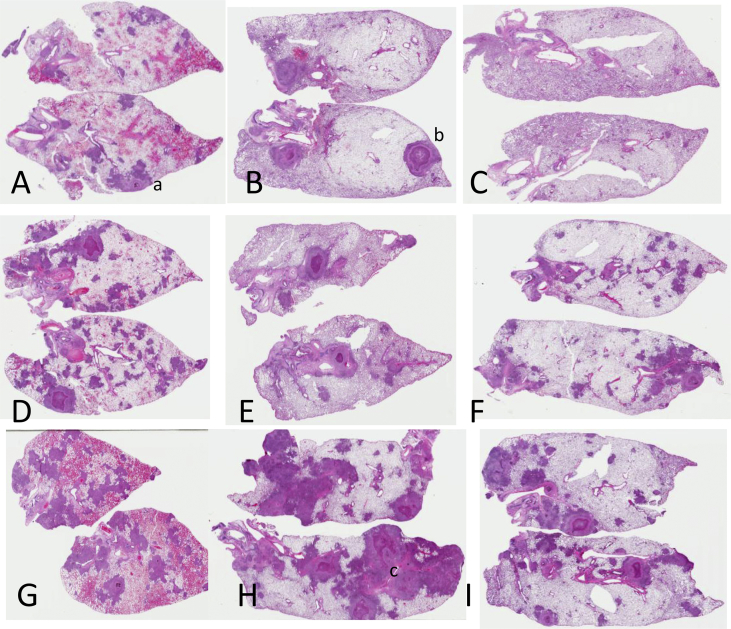
Representative whole lung scans from infected guinea pigs harvested on day-60 of the infection. Hematoxylin and eosin staining. The top row [A-C] are high transmission strains 708, 1009, and 212. The middle line [D-F] are moderately transmitted strains 138, 433, and 547. The bottom row [G-I] are unique strains 923, 1125, and 1115, in which no transmission has been observed. Features in A-C consist of scattered granulomas, some on the pleural surface [“a”] with others showing obvious central necrosis [“b”]. In D-F there are substantially more lesions, and in G-I some of these are severe and there is obvious granulomatous consolidation [“c”].